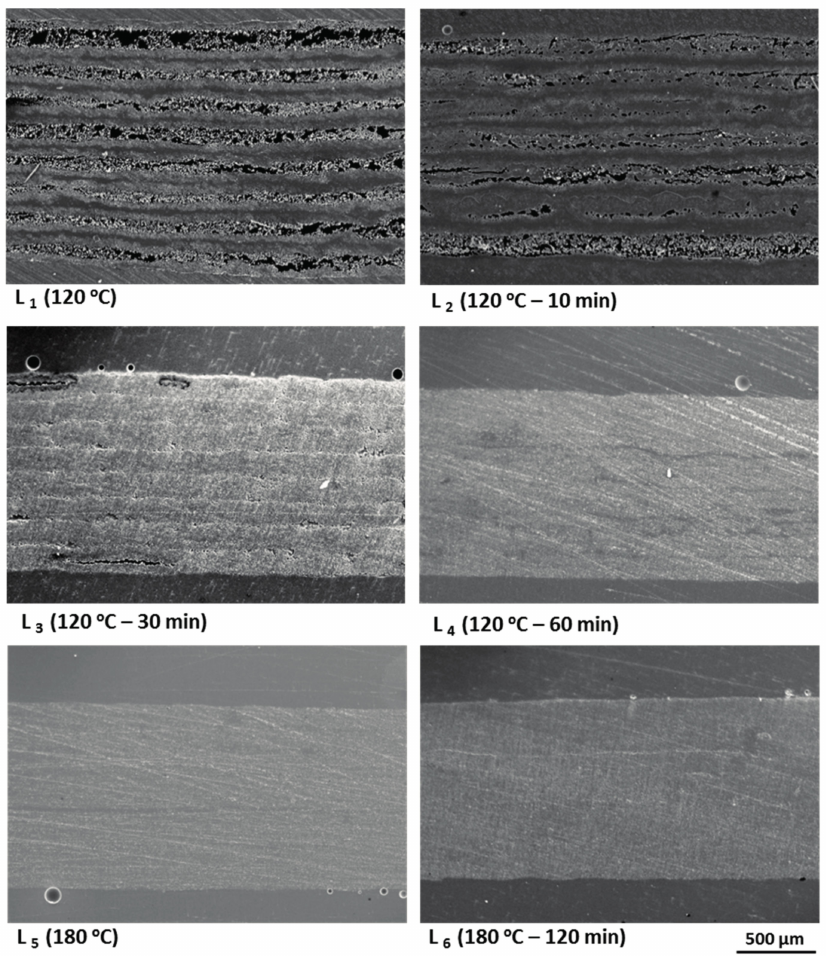
Figure 13. Optical micrographs of resin impregnation in laminates during a rapidly cured process.